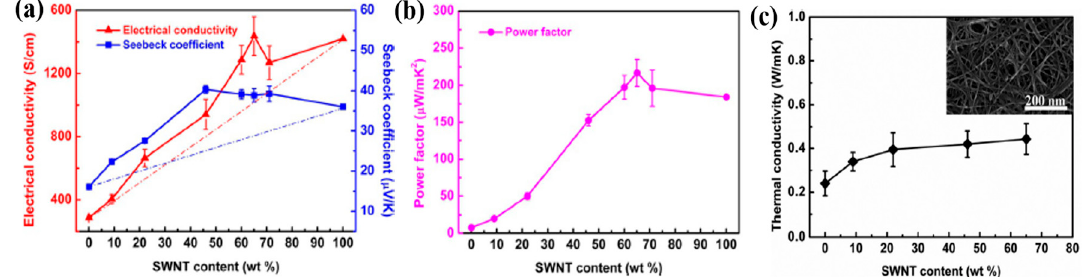
Figure 7. ( a ) The electrical conductivity and Seebeck coefficient, ( b ) power factor, and ( c ) thermal conductivity at room temperature of the PANi/single carbon nanotubes (SWNT) composites. The inset is the SEM image of PANi/SWNT composites with SWNT content of 65 wt%. Reprinted with